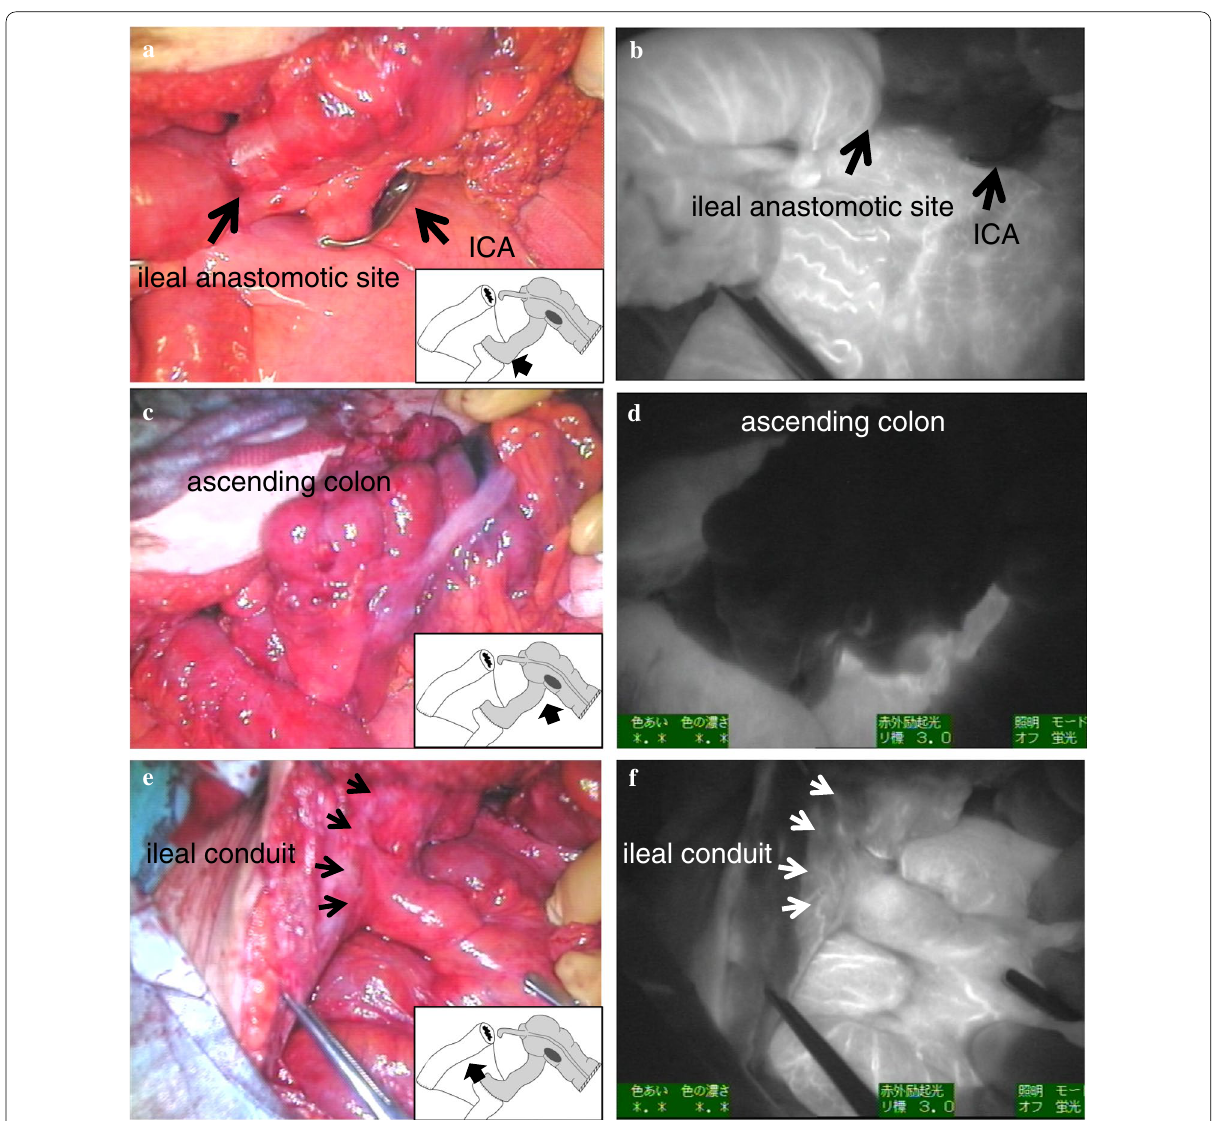
Fig. 3 Assessment of bowel perfusion after clamping of the ileocecal artery (ICA) and marginal artery on the oral side of the ileal anastomotic site. Bowel perfusion under normal light ( a , c , and e ) and under ICG fluorescence imaging ( b , d , and f ). Intestinal segment from the ileal anastomotic site ( b ) to the ascending colon ( d ) showing a negative staining area, i.e. ischemic area. The ileal conduit showing the positive staining area, i.e. non-ischemic area ( f